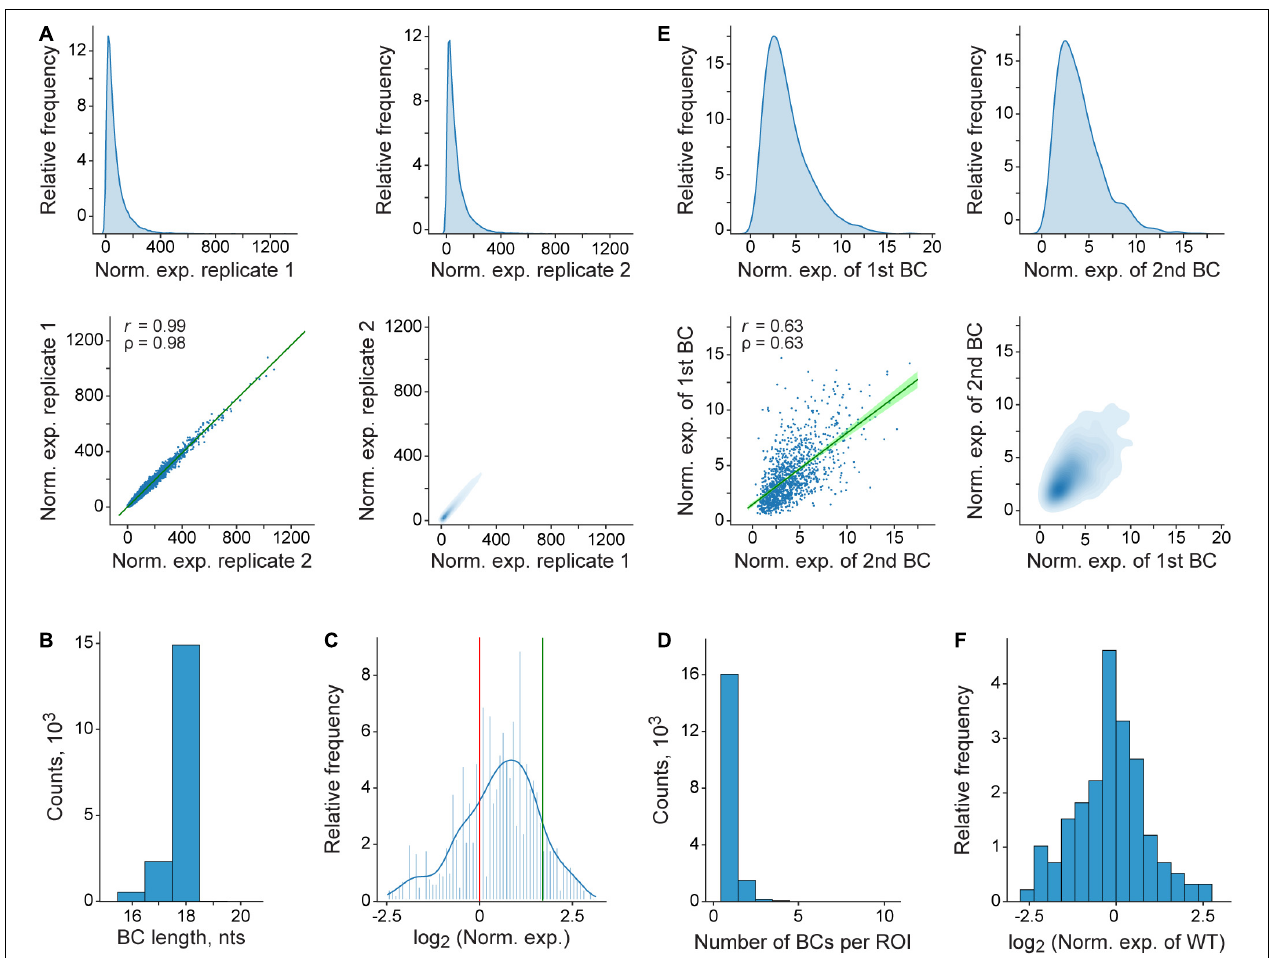
FIGURE 4 | Representative plots generated by the pipeline. (A) Distribution and correlation of normalized expression values for the entire MPRA library. At the top, density plots of normalized expression values obtained for genuine BCs in each of the two replicates are shown. At the bottom, the correlation of these values between the replicates is visualized as regular (left) and density (right) scatterplots. In the left scatterplot, the regression line and 99% confidence intervals are shown in green; r and ρ denote Pearson’s correlation coefficient and Spearman’s rank correlation coefficient, respectively. (B) Genuine BC length distribution for the entire MPRA library. (C) Histogram and a kernel density estimation of normalized expression values for the entire MPRA library that were averaged over replicates and normalized to the wild-type reference construct. The expression levels of the wild-type and the deltaC mutant references are indicated by red and green vertical lines, respectively. (D) Distribution of the genuine BC number per ROI for the entire MPRA library. (E) Effect of the BC sequences on normalized expression values as estimated by using a subset of the ROIs, each associated with more than one BC. For each such ROI, only two different BCs, which are randomly assigned to groups “1st BC” and “2nd BC” are used for the comparison (for the ROIs associated with three or more BCs, only two of them are randomly sampled). At the top, density plots of normalized expression values obtained for BCs from the groups “1st BC” and “2nd BC” are shown. At the bottom, the correlation of these values between the groups is visualized as regular (left) and density (right) scatterplots. The rest of the description of the left scatterplot is as in (A) . (F) Distribution of normalized expression values of genuine BCs, each associated with the ROI of the wild-type (WT) sequence. For (A–F) , it is worthwhile noting that the plots shown were generated by using the entire fastq file obtained (see section “Materials and Methods”), from which the example data set was randomly sampled.